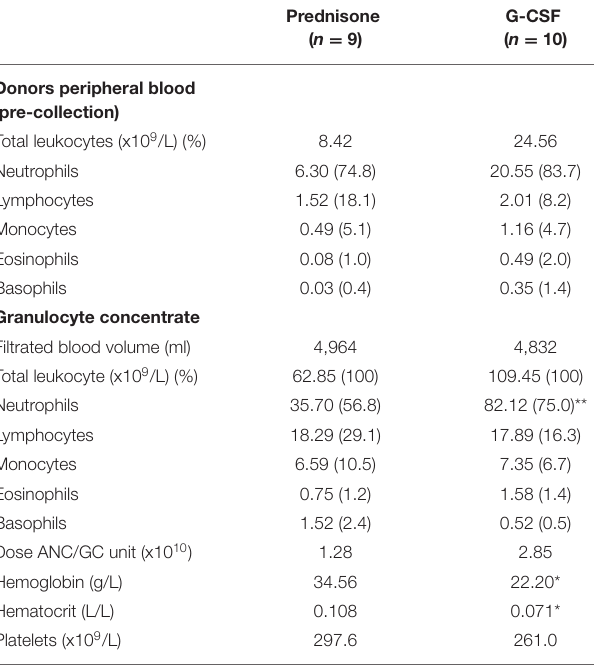
Prednisone G-CSF ( n = 9) ( n =